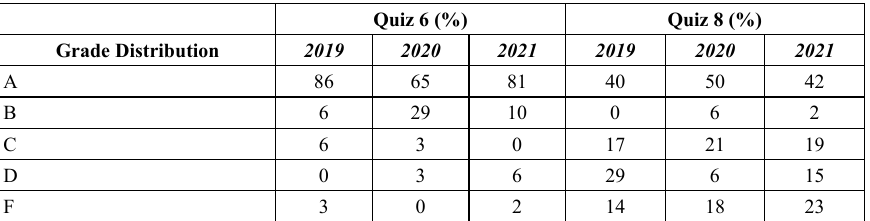
Fig. 1. Performance of the students from the three cohorts in the quizzes Table 2. Distribution of grades in two